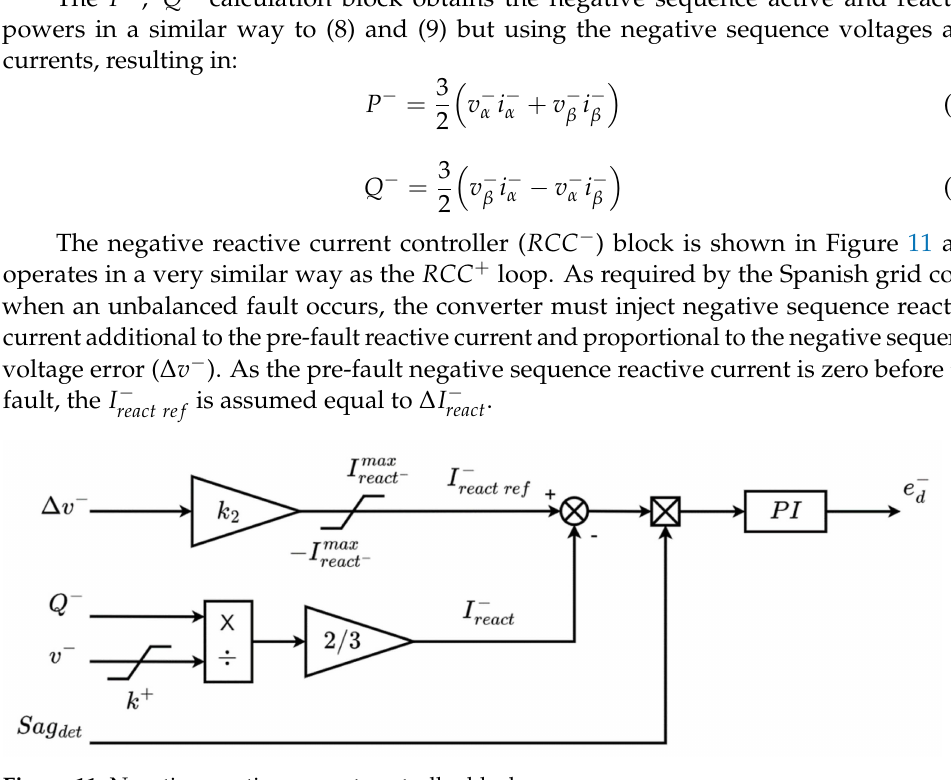
Figure 11. Negative reactive current controller